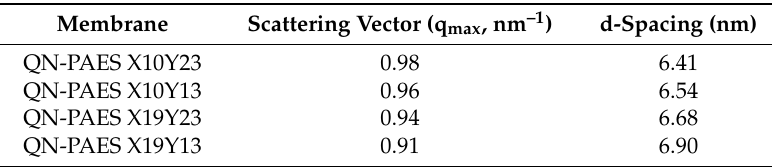
Figure 8. The SAXS patterns of QN-PAES membranes.